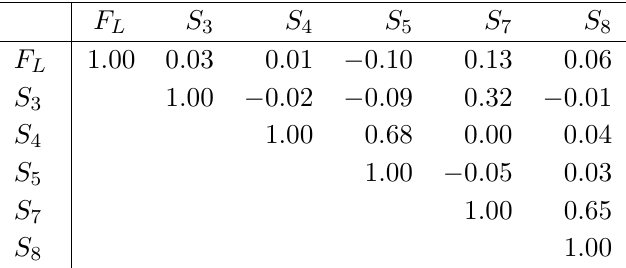
and S parameters obtained for q 2 2 L